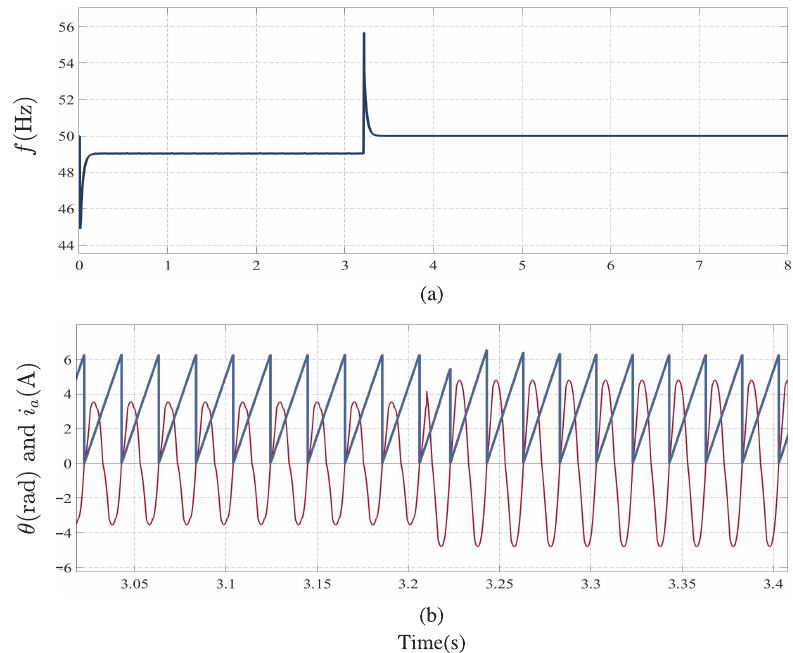
Figure 15. Experimental results: ( a ) frequency. ( b ) Comparison between θ and i a .